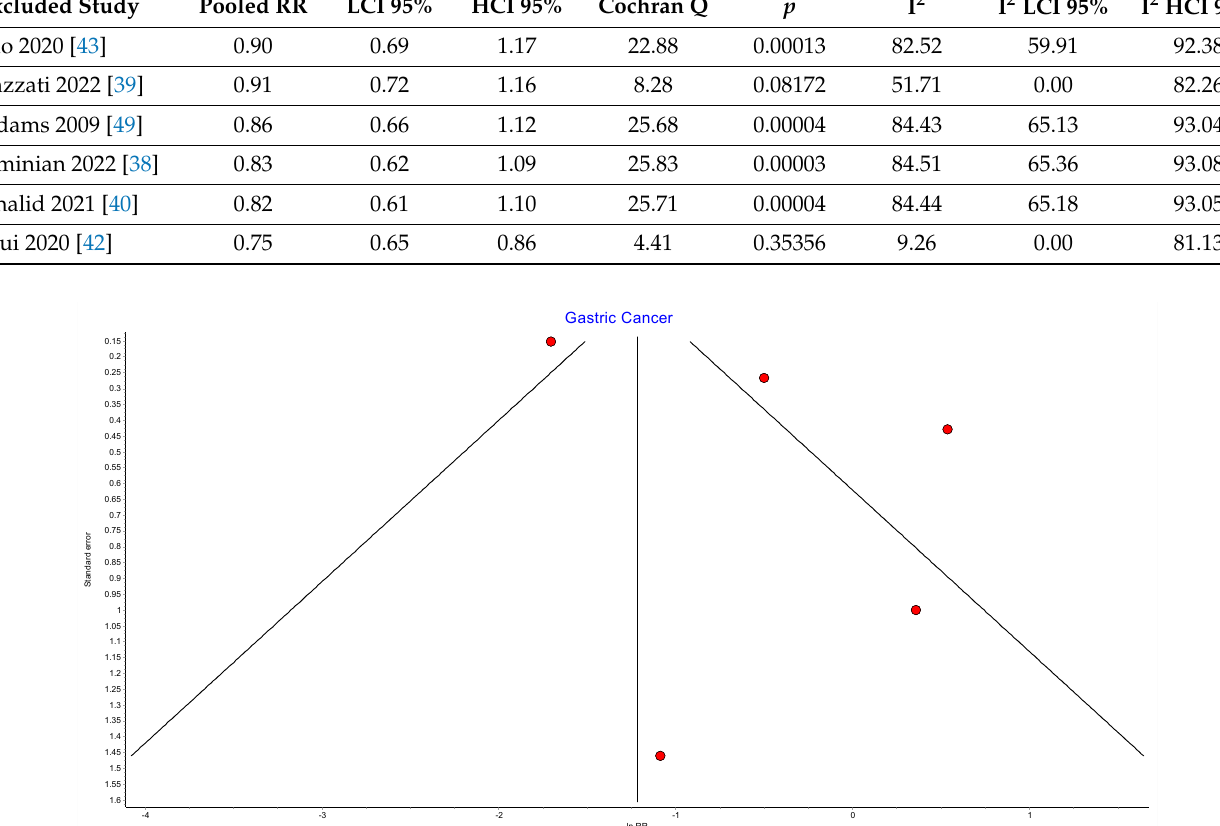
Figure A19. Gastric cancer random effects model funnel plot.